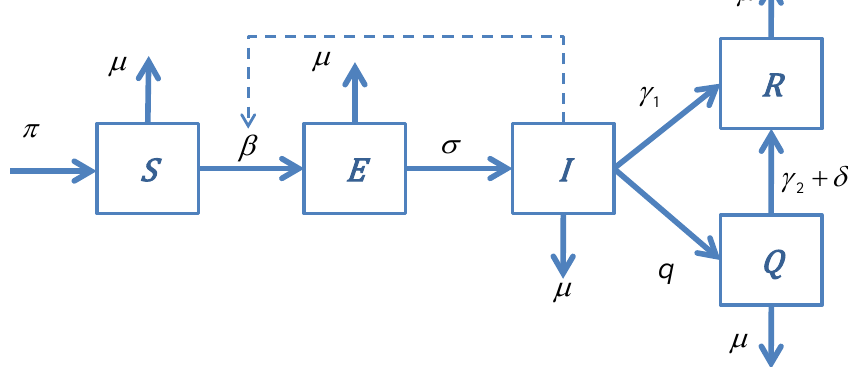
Figure 1. Schematic diagram of the flow of individuals between the